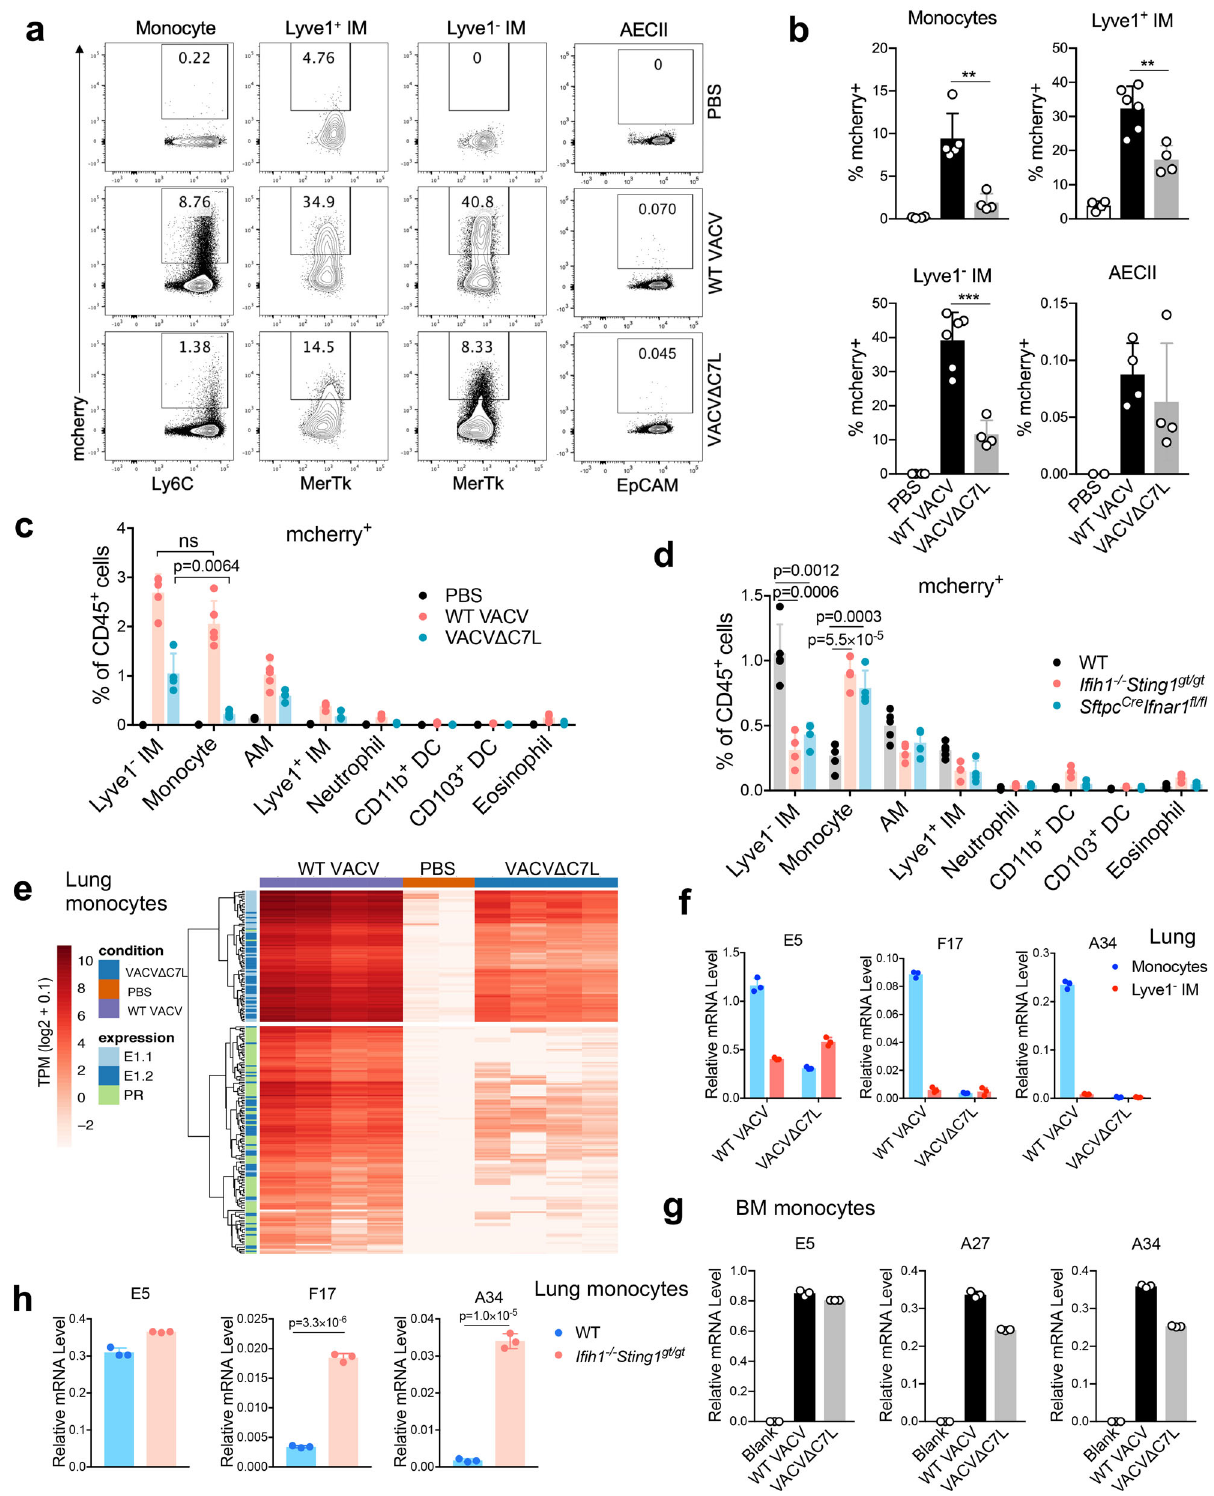
pattern-recognition receptors (PRRs) are responsible for IFN production and how IFN exerts its function during a pulmonary poxvirus infection. In this study, we established an acute poxvirus infection model with an attenuated but replication-competent mutant VACV (VACV Δ C7L) via the deletion of a host range